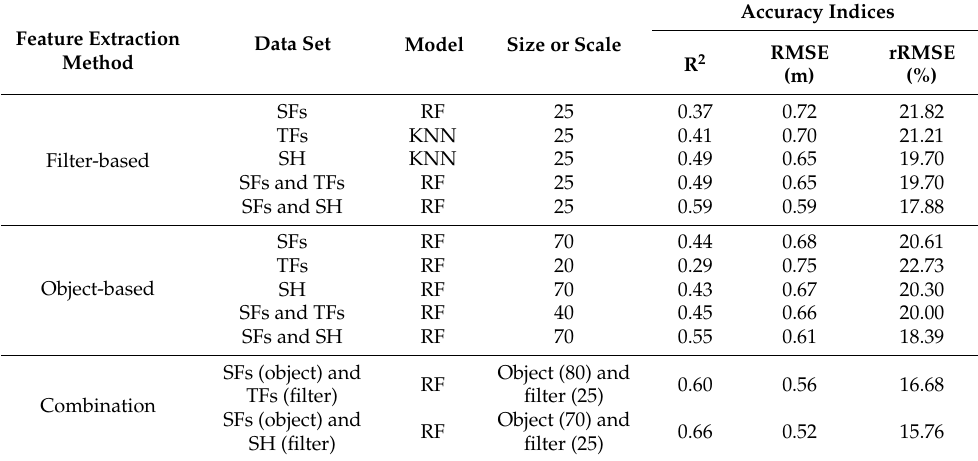
Table 3. Optimal estimation results for each optimal variable